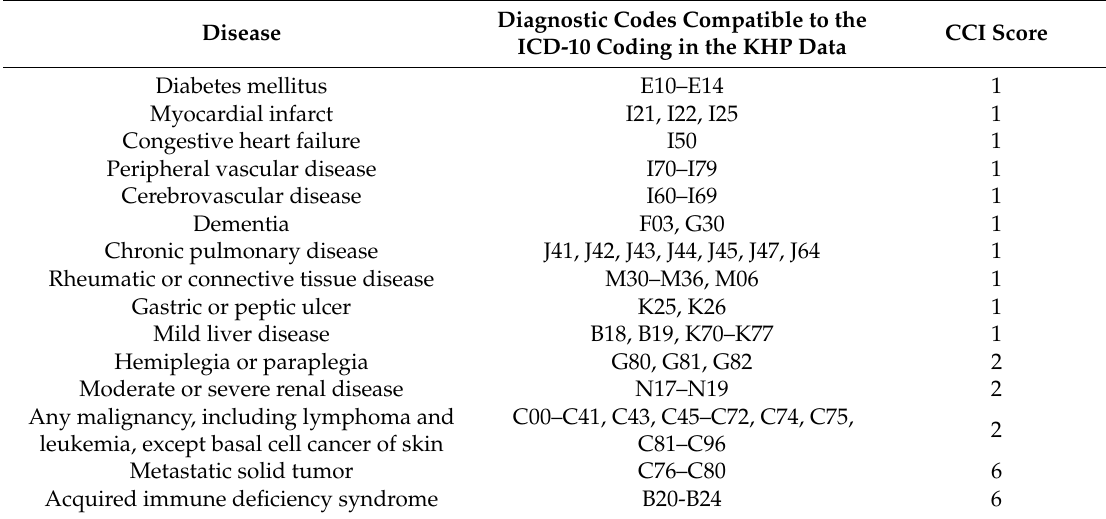
Table 1. Diagnostic codes for calculating Charlson comorbidity index score in adults ( ≥ 18 years) with hypertension—based on the 2013 Korea Health Panel